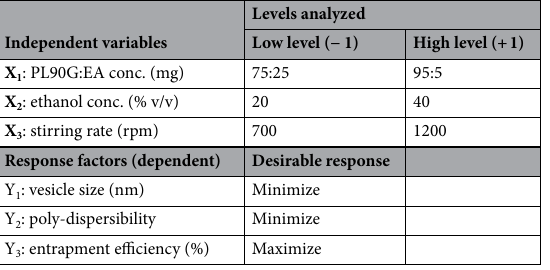
Table 1. Independent variables and response factors opted for optimization of